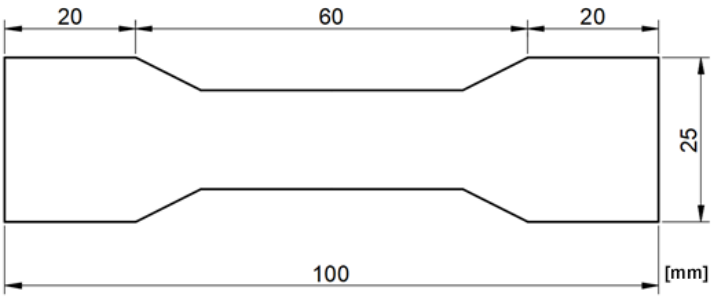
Figure 1. Geometry of testes samples.